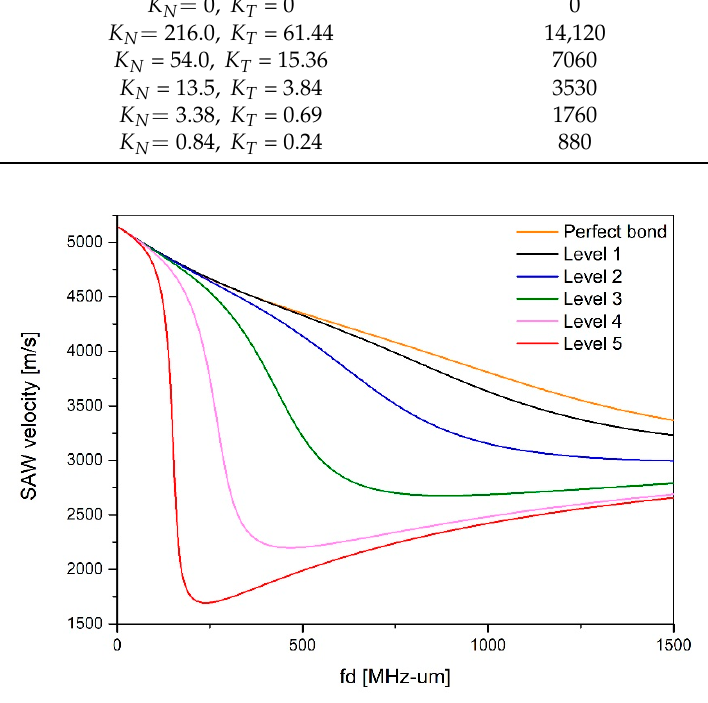
Figure 2. Dispersion curve simulation according to interface